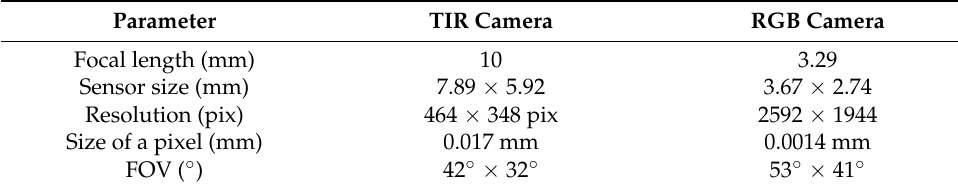
Table 2. Parameters of TIR camera and RGB camera of FLIR